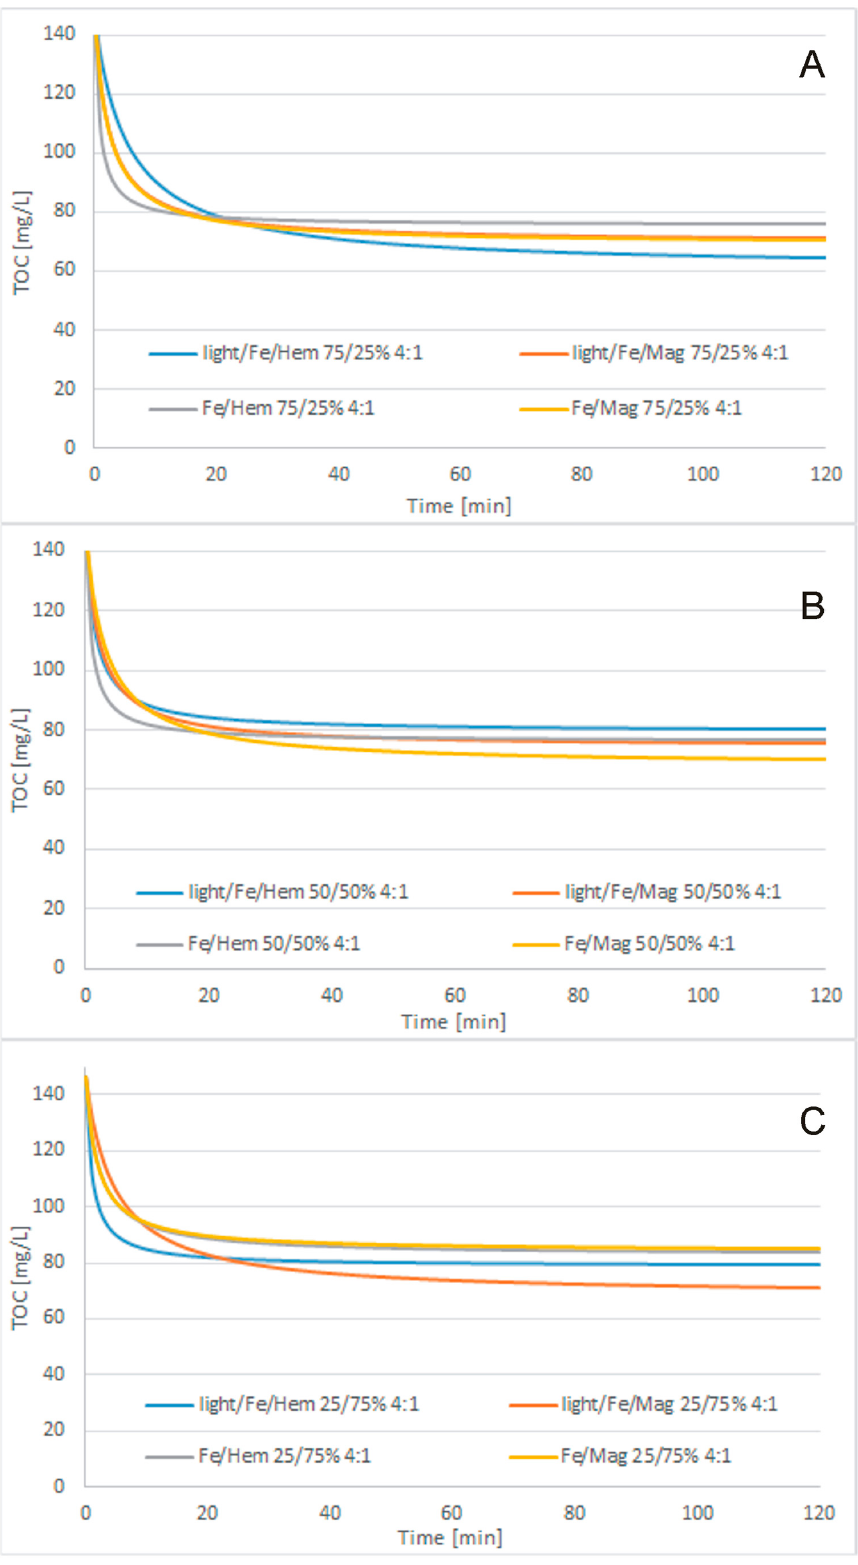
Figure 5. Cosmetic wastewater treatment, modified 2nd-order kinetic model matching results, 4:1 H 2 O 2 /COD ratio, catalyst ratio: ( A ) 75/25 Fe/Iron oxide, ( B ) 50/50 Fe/Iron oxide, ( C ) 25/75 Fe/Iron oxide.